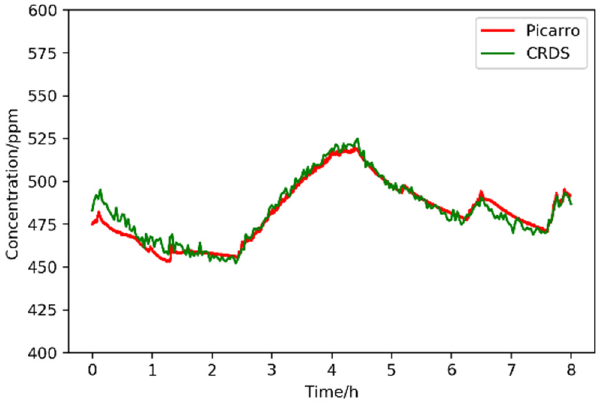
Figure 8. Comparison of this sensor to one commercial CRDS instrument (G2201-i, Picarro, Santa Clara, CA, USA).